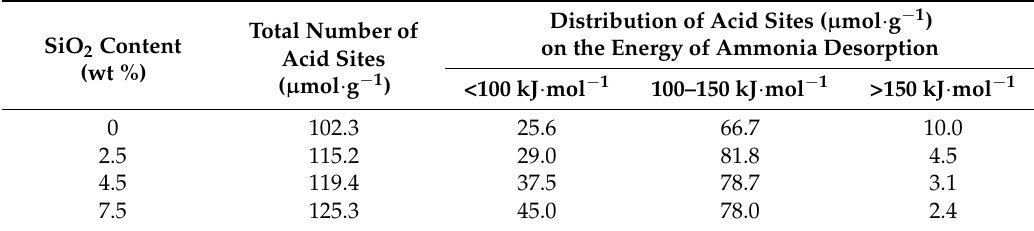
Figure 7. NH 3 -TPD (temperature programmed desorption) patterns of initial and SiO 2 -modified Figure 7. NH 3 ‐ TPD (temperature programmed desorption) patterns of initial and SiO 2 ‐ modified supports. supports. Table 3. Results from NH 3 -TPD (temperature programmed desorption) measurement of Table 3. Results from NH 3 ‐ TPD (temperature programmed desorption) measurement of supports.